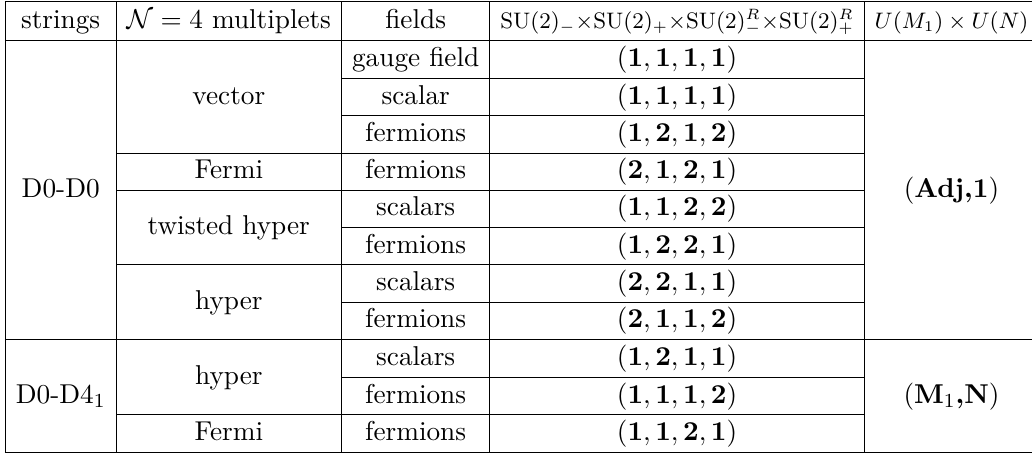
Table 2 . The field content of the D0-D4 quantum mechanics. Note that 1d twisted multiplets does not have a matrix model counterpart. Indeed, the field decouples from the computation of the index.